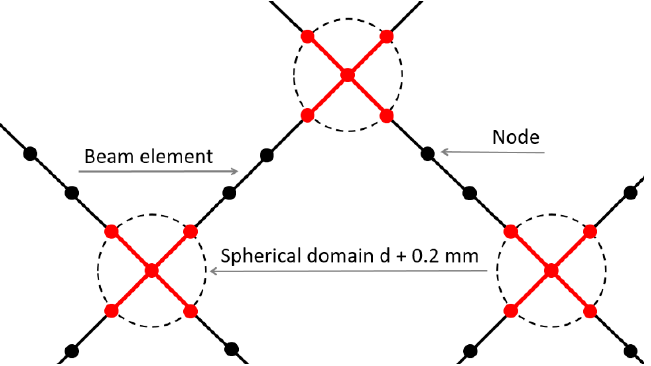
Figure 5. Schematic composition of elements and nodes with different properties.